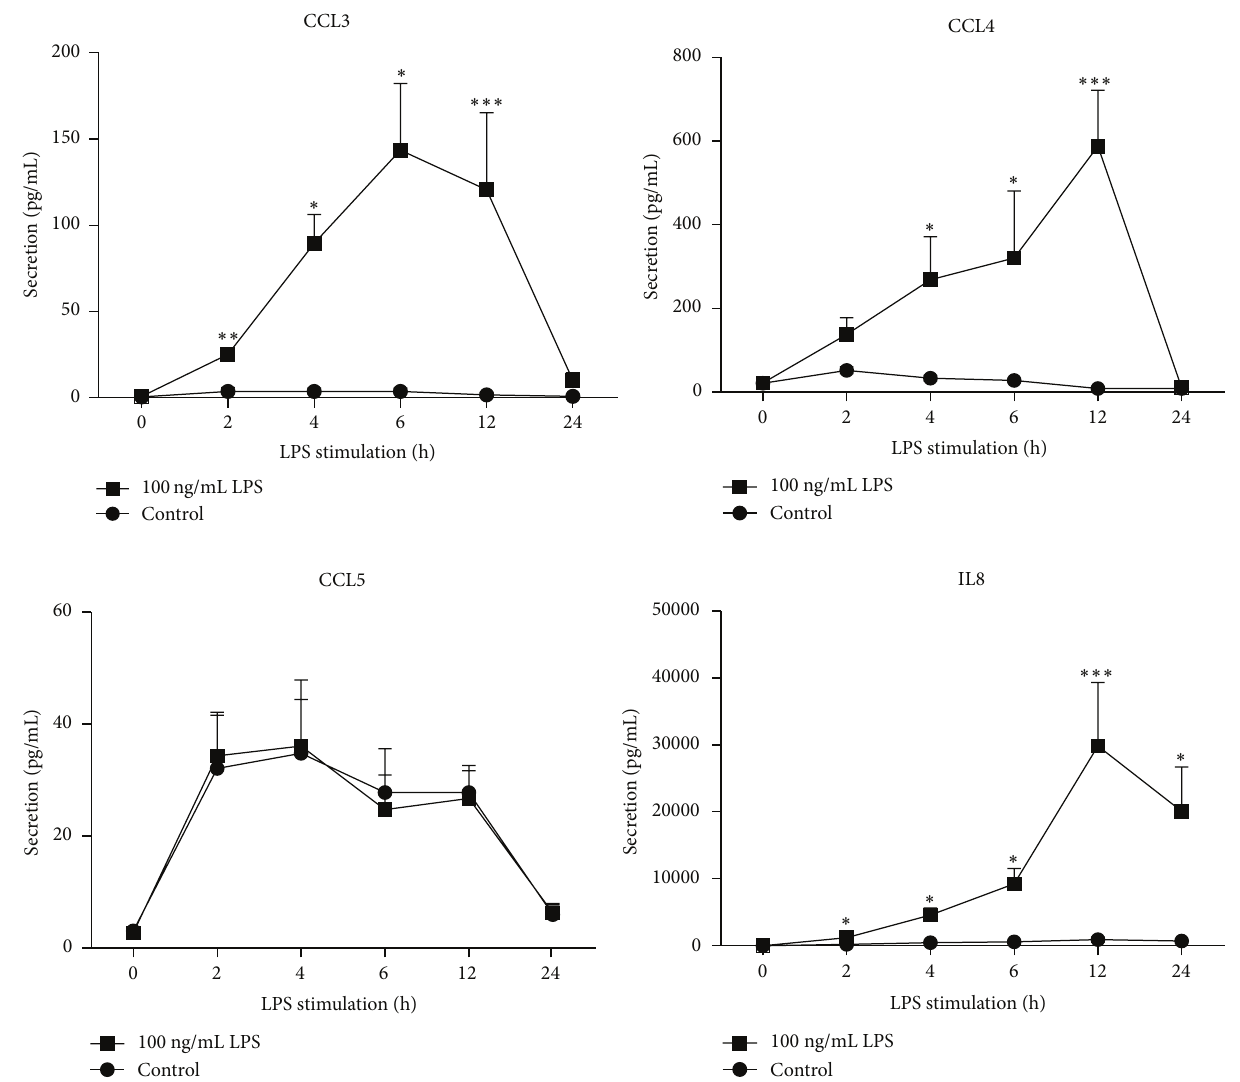
Figure 1: Time-dependent effect of LPS on cytokine secretion in human neutrophils. Cytokine secretion was measured by CBA upon stimulation with 100ng/mL LPS for 0h, 2 h, 4h, 6h, 12 h, and 24 h. Results are mean secretion (pg/mL) ± SEM of at least 3 independent experiments, significantly different from cytokine secretion in nonstimulated control at the corresponding time: ∗ 𝑝 < 0.05 , ∗∗ 𝑝 < 0.01 , ∗∗∗ 𝑝 < 0.001 , and ∗∗∗∗ 𝑝 < 0.0001 .